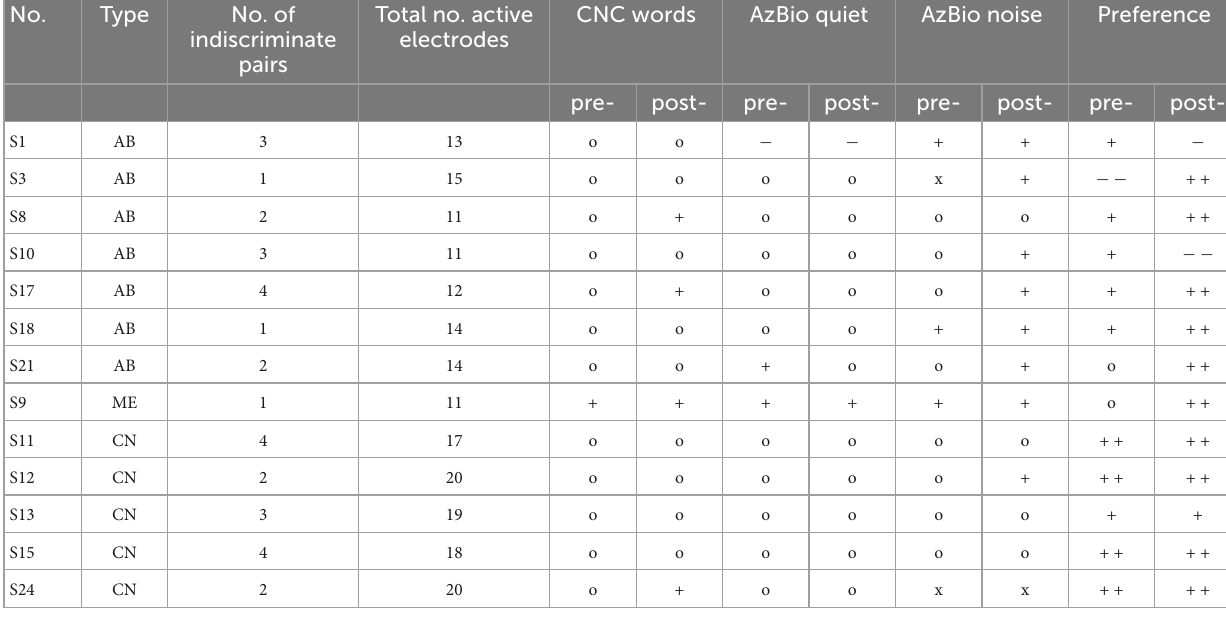
TABLE 2 A summary of participant